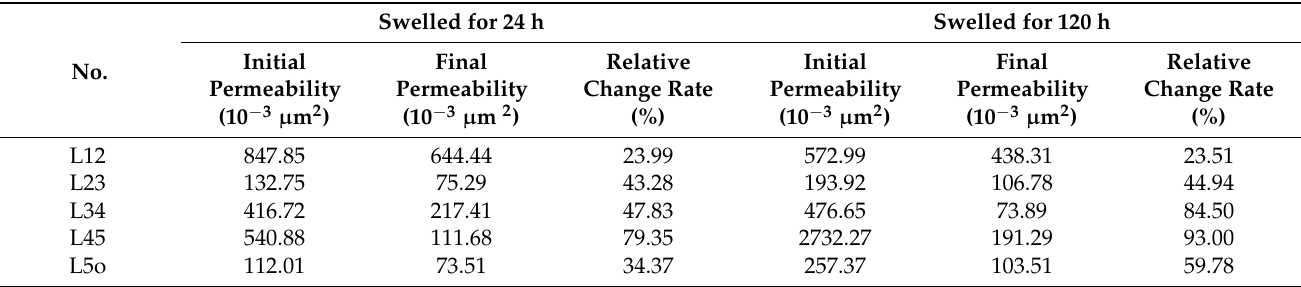
Figure 12. Variation curves of the pressure and permeability with the injection time in different locations of the sand packs before and after the injections of SiO 2 /P(MBAAm- co -AM) polymeric nanoparticles swelled for 24 h ( a , b ) and swelled for 120 h ( c , d ). Table 1. Relative change rates of the permeabilities between the measuring points in the sand packs before and after the profile